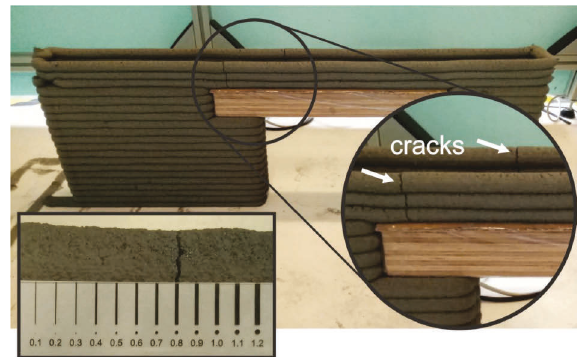
Figure 26: Cracks in printing components